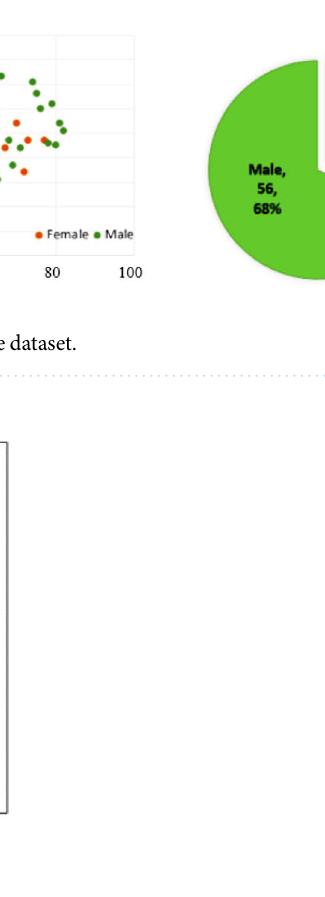
Figure 4. The distribution of the lung area to the image area in COVID-CT-Rate dataset.